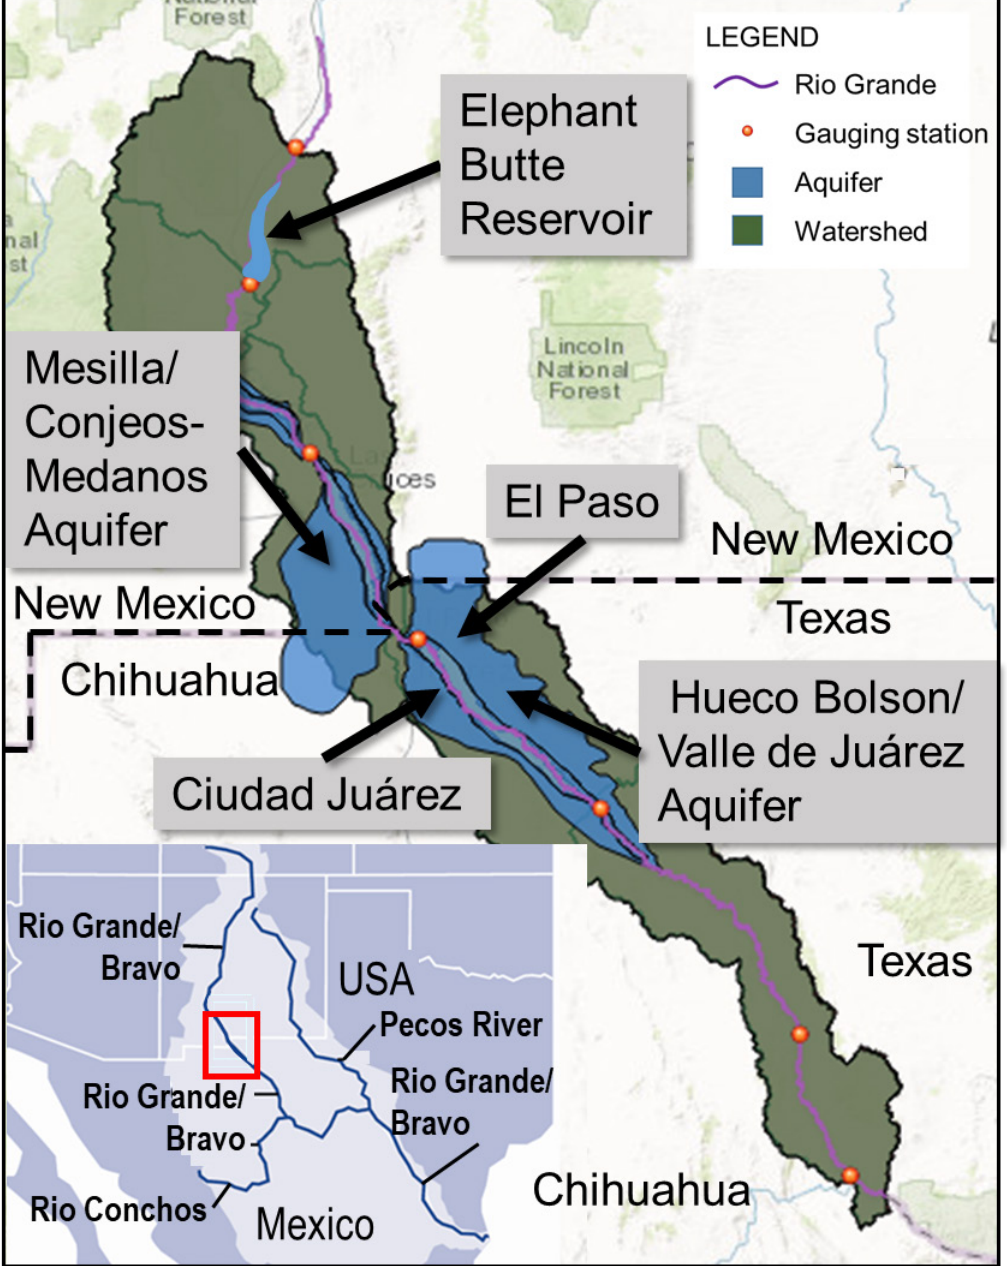
Figure 1. Study area.